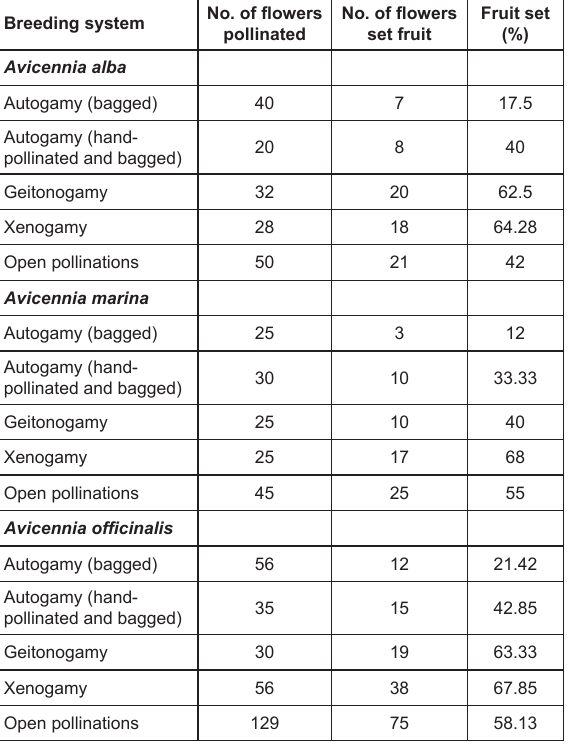
Table 1. Results of breeding experiments in Avicennia species Breeding